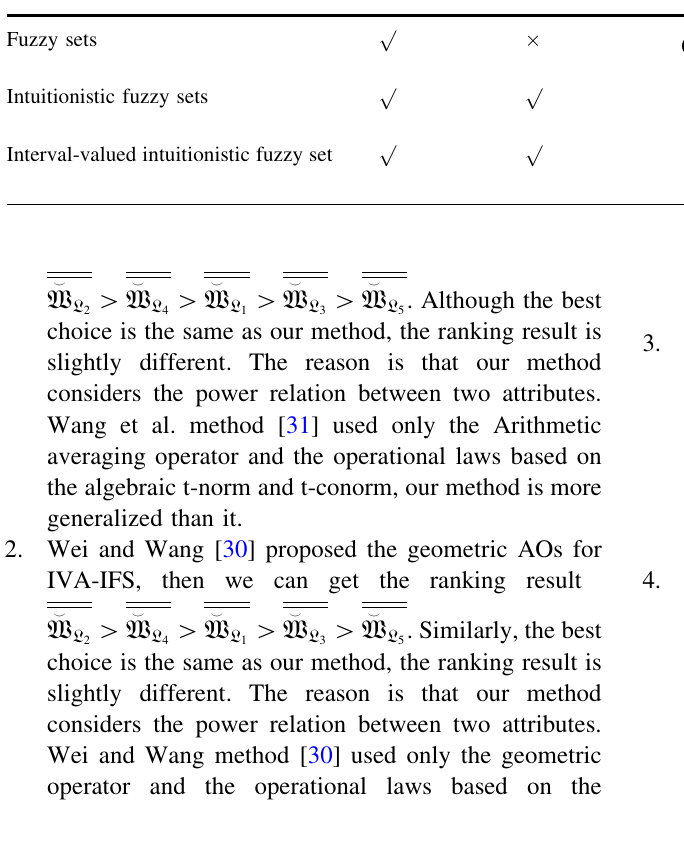
Table 10 Theoretical analysis of the proposed work Methods Truth grade Falsity grade Condition